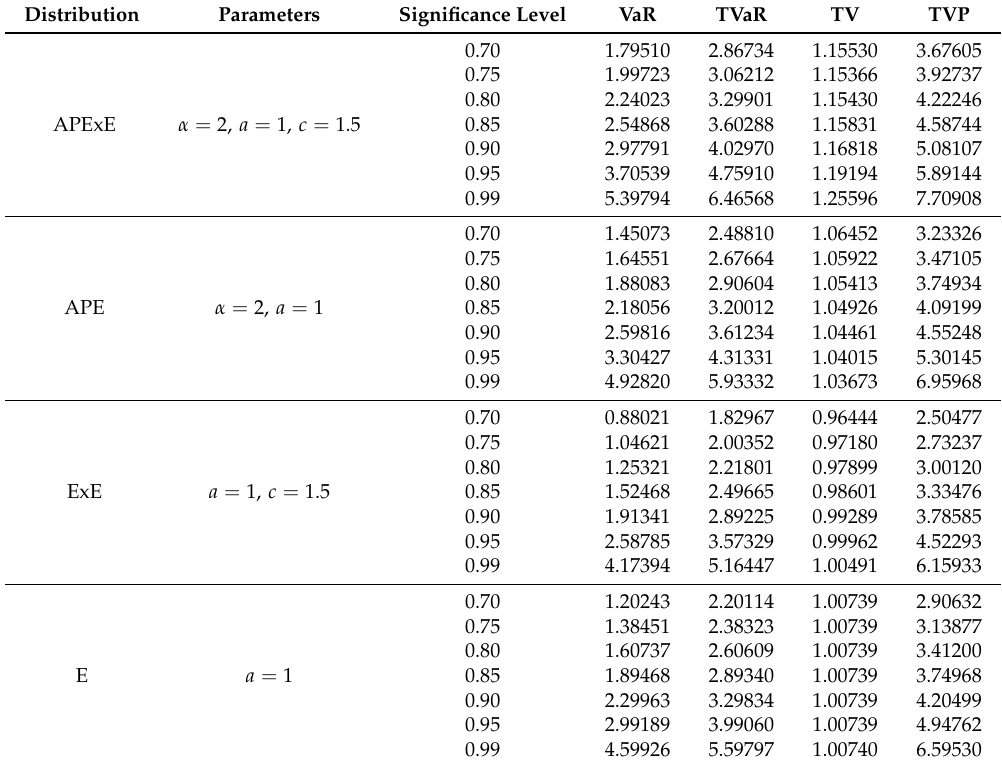
Table 3. Simulation results for the VaR, TVaR, TV, and TVP of the APExE, APE, ExE, and E